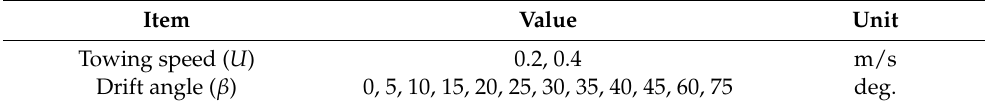
Table 3. Oblique towing test conditions.